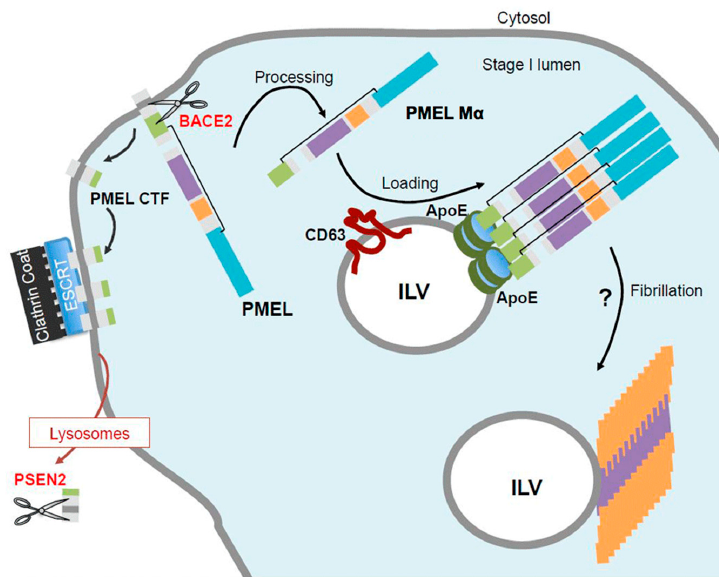
Figure 3. Model for pre-melanosomal protein (PMEL) fibril formation in stage I melanosomes. The amyloidogenic M α fragment of PMEL is released into the lumen of stage I melanosomes by action of BACE2 (beta-site APP cleaving enzyme 2) protease. This cleavage also produces a C-Terminal Fragment (CTF) that is sequestered at the limiting membrane of stage I melanosomes by the endosomal sorting complexes required for transport (ESCRT) machinery, to be further cleaved by the presenilin 2 (PSEN2) of the γ -secretase complex in lysosomes. The M α fragment is then loaded onto intraluminal vesicles (ILVs) in a process that requires the tetraspanin CD63 (cluster of differentiation 63) and apolipoprotein E (ApoE). ILVs have been proposed to act as nucleators for PMEL fibril formation. One may speculate that CD63 and ApoE cluster PMEL on ILVs, thus promoting its fibrillation. However, it remains to characterize the unknown mechanism and proteases (indicate as ?) involved in PMEL fibrillation.